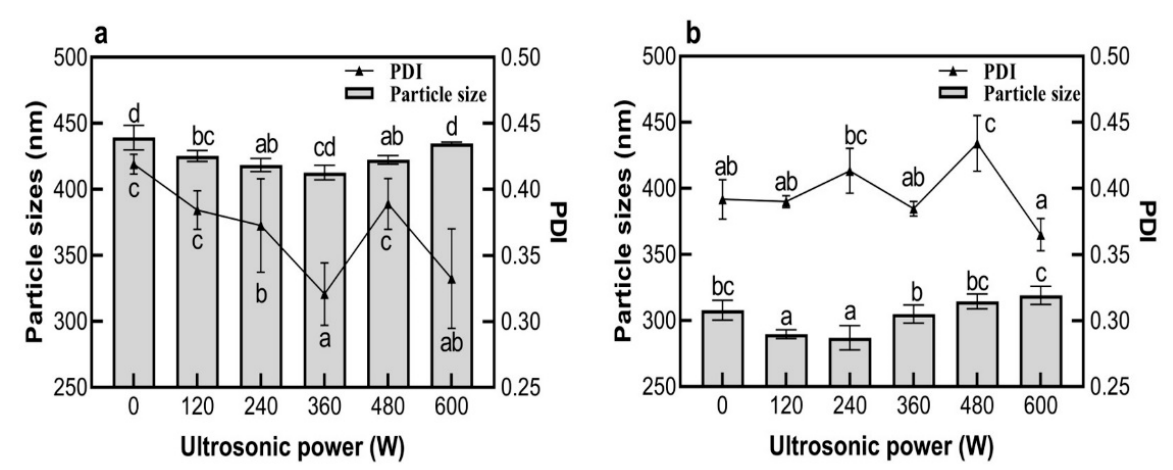
Figure 1. Effect of ultrasonic power on the particle size of EWP-GPs ( a ) and EWP-GPs with TGase treatment ( b ) of EWP-GPs. (Values with different letters are significant at p < 0.05.)